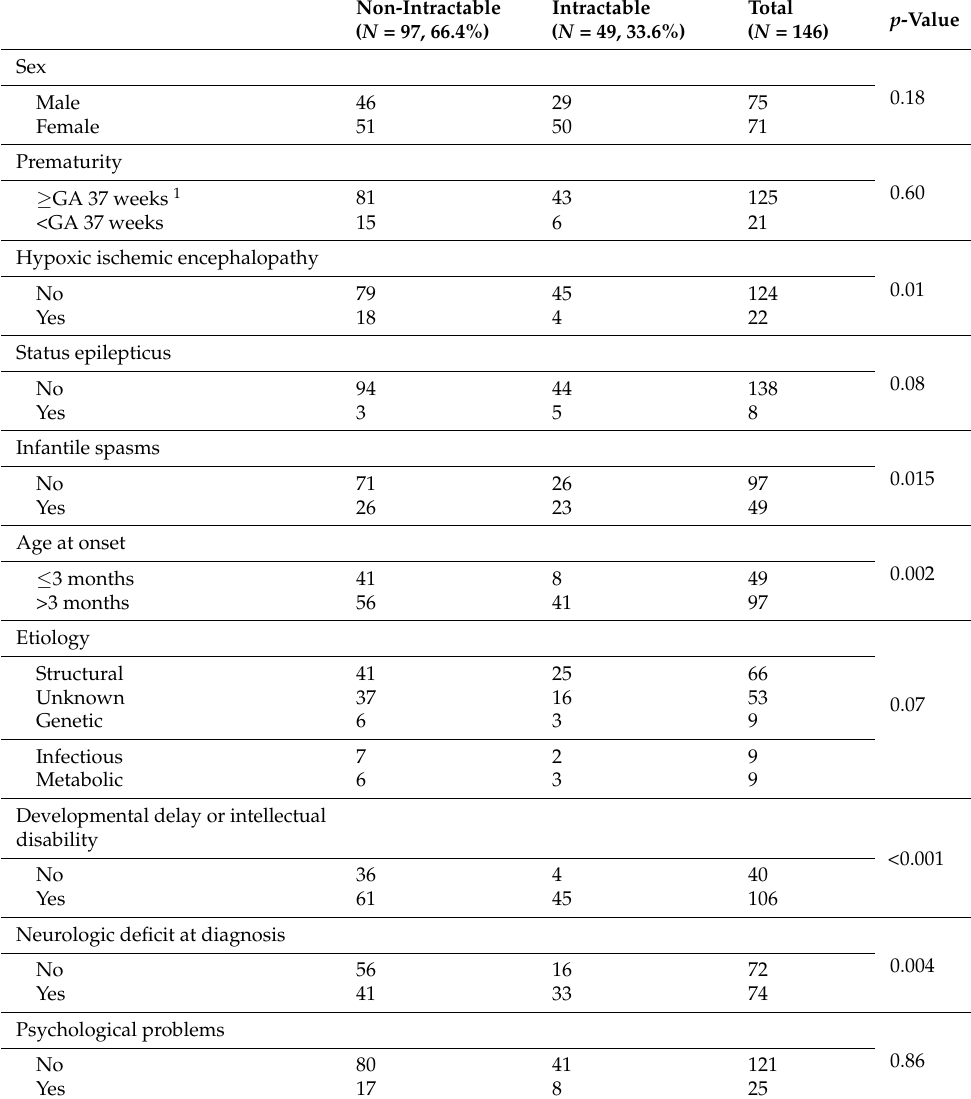
Table 2. Univariate analysis for intractability at last